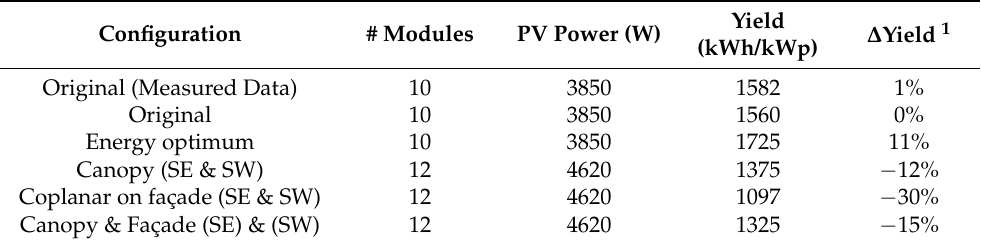
Yield ∆ Yield 1 (kWh/kWp)